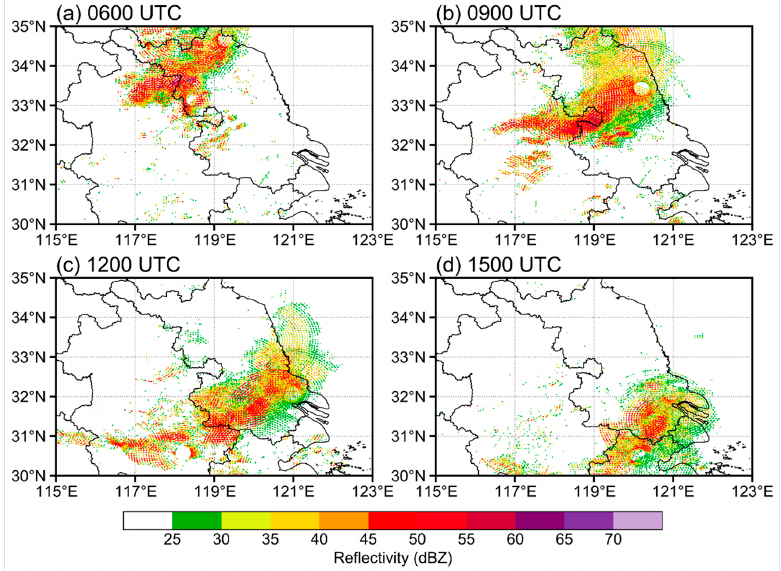
Figure 8. Composite reflectivity observation for the fast-moving squall line case on 6 July 2019 (units: dBZ). ( a ) 0600 UTC, ( b ) 0900 UTC, ( c ) 1200 UTC, ( d ) 1500 UTC. dBZ). ( a ) 0600 UTC, ( b ) 0900 UTC, ( c ) 1200 UTC, ( d ) 1500